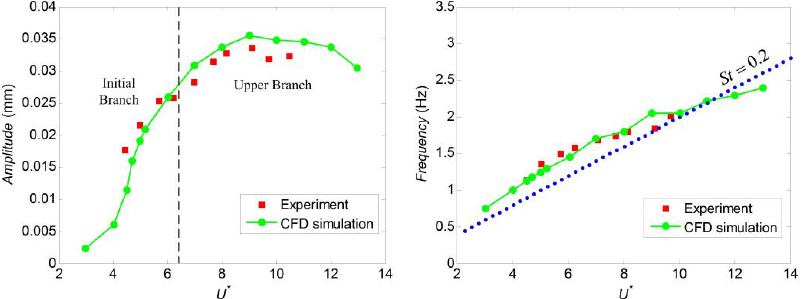
Figure 6. Comparison of amplitude and frequency responses between the numerical results and the experimental results.